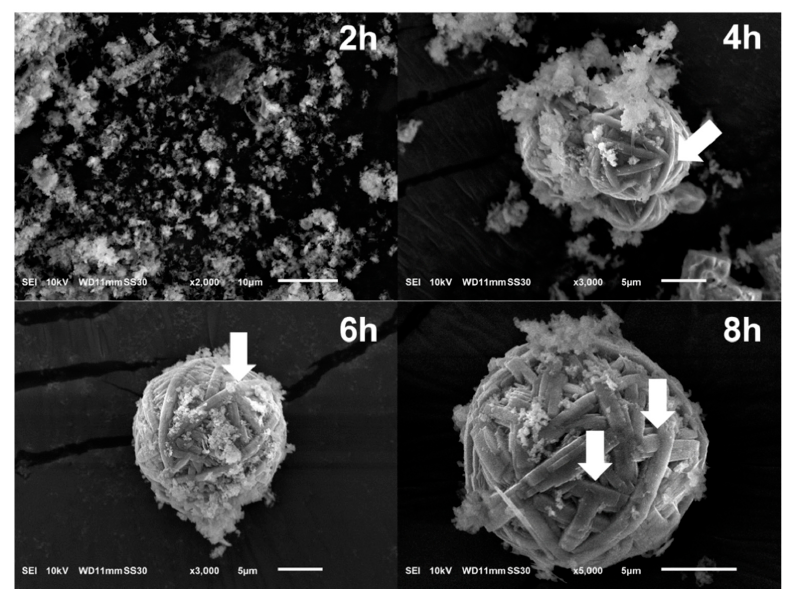
Figure 4. DBM obtained after hydrothermal treatment for various durations. The white arrows indicate the positions where the fibers branched.